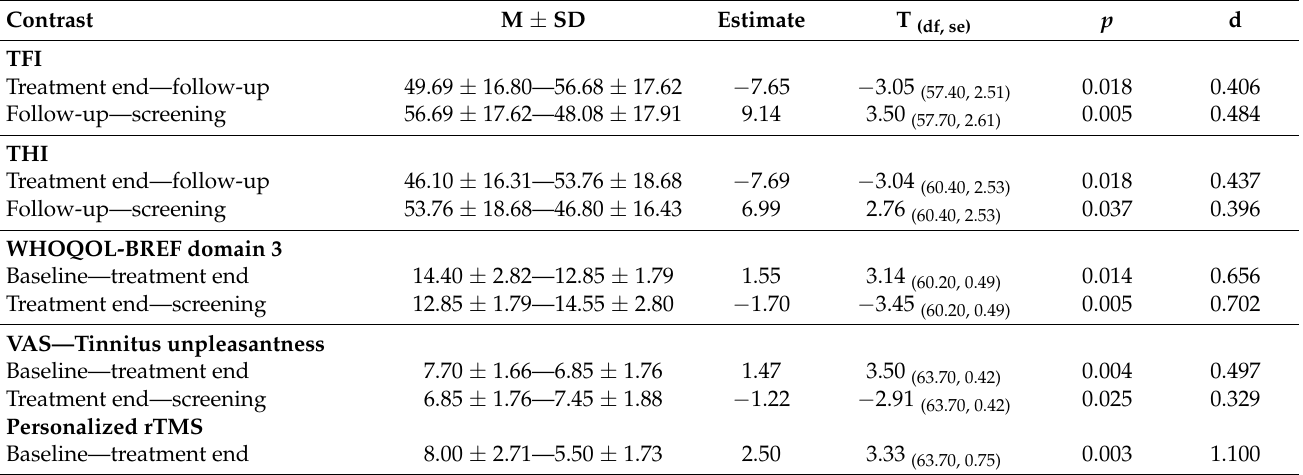
Table 2. Post hoc Tukey